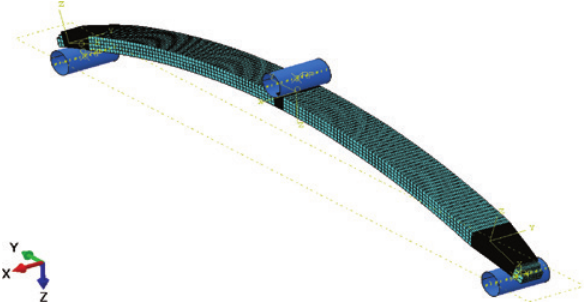
Figure 5: Meshed composite leaf spring